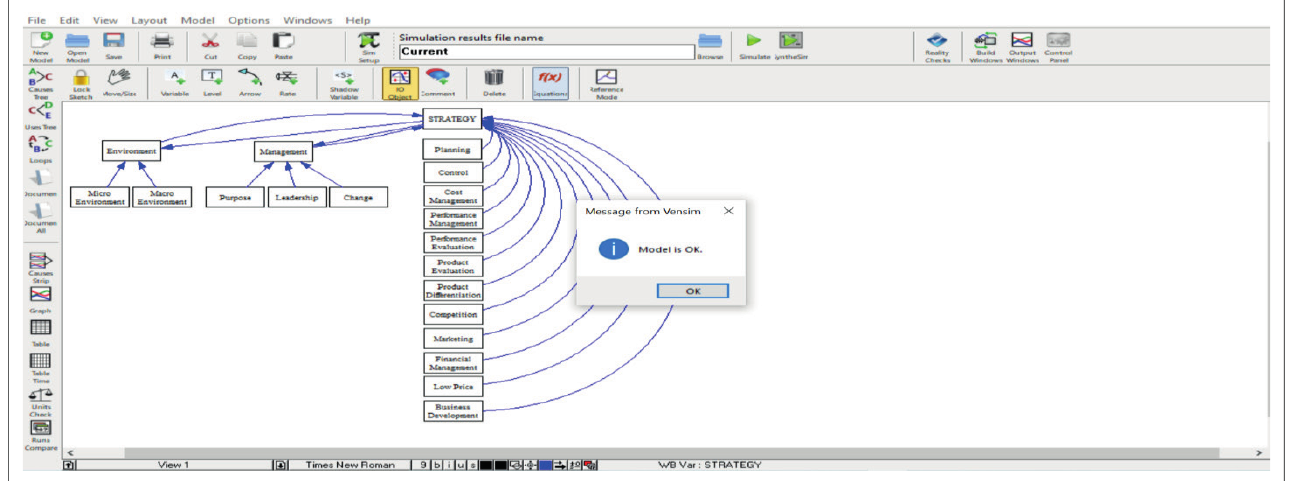
FIGURE 4: The strategy, change, purpose and leadership model – Run successfully (Vensim™/®/© version